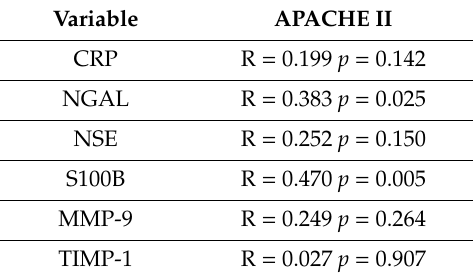
Table 6. Correlations between APACHE II and the studied biomarkers 1